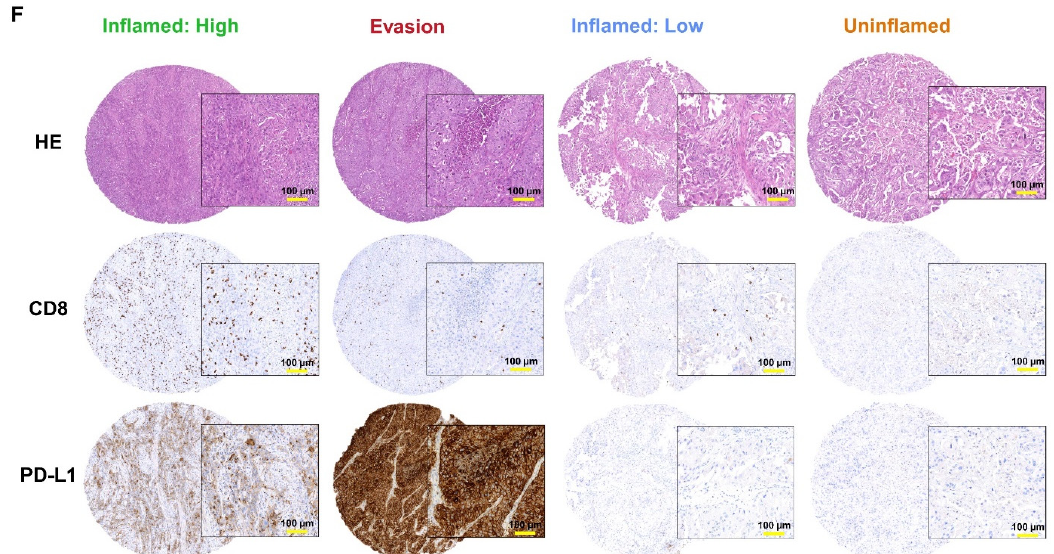
Figure 3. Immune biological correlates of PD-L1 scoring algorithms. ( A ) Overall immune infiltration (immune cell infiltration score; ICIS) according to PD-L1 scoring algorithms and respective cut-offs for PD-L1 negativity and positivity. ( B ) Unsupervised hierarchical cluster analysis of individual immune cell populations estimated at the invasion front and tumor center together with PD-L1 consensus scoring results (CPS, Ventana IC score, TPS/TC area score, IC area score) reveals four immune biological cluster groups: “Inflamed: High”, “Evasion”, “Inflamed: Low”, and “Uninflamed”. Stromal tumor-infiltrating lymphocyte count, overall CD8 + -infiltration, and PD-L1 classification results according to CPS10, Ventana IC5%, and TC area 25%/IC area 25% are depicted above the heat map in H-bar plots. ( C ) General immune infiltration (ICIS) according to cluster groups. Disease-specific ( D ) and disease-free survival ( E ) according to cluster groups. Univariable log-rank p -values and multivariable hazard ratios (HR) derived by Cox regression analyses are depicted below survival curves. Detailed multivariable survival models are summarized in Table S3. All multivariable Cox regression analyses exploring the displayed indicator variables were adjusted for pT-Stage, pN-Stage, lymphovascular invasion (L), age, gender, resection margin status, receipt of an adjuvant platinum-containing chemotherapy regimen, and tumor grading (WHO2016 and WHO1973). Patients at risk at various milestones are depicted below survival curves. ( F ) Representative images of HE morphology, CD8 + -infiltration, and PD-L1 expression on IC or TC according to the four cluster groups; TMA core images were taken in 50 × magnification, magnified snapshots were taken in 200 × magnification. Abbreviations: CPS = combined positivity score; HR = hazard ratio; IC = immune cell (s); ICIS = immune cell infiltration score; TC = tumor cell